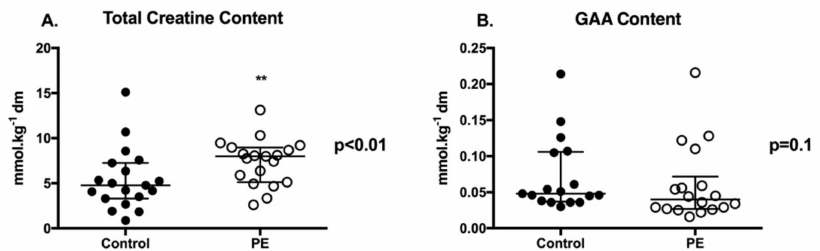
Figure 1. Placental Creatine and Creatine Precursor Guanidinoacetate (GAA) Content. Total creatine ( A ) and GAA ( B ) content of n = 19 healthy control (closed circle) and n = 19 PE (open circle) placentae. Two sample t-tests were used for statistical comparison. Data are present means ± SD. ** p <